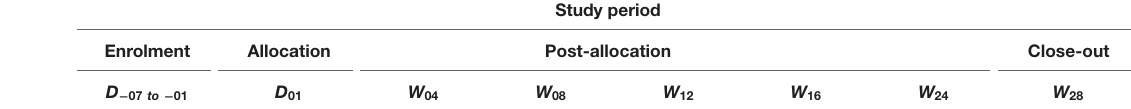
TABLE 3 | Schedule of enrolment, interventions, and assessments. Study period Enrolment Allocation Post-allocation Close-out D 01 W 04 W 08 W 12 W 16 W 24 W 28